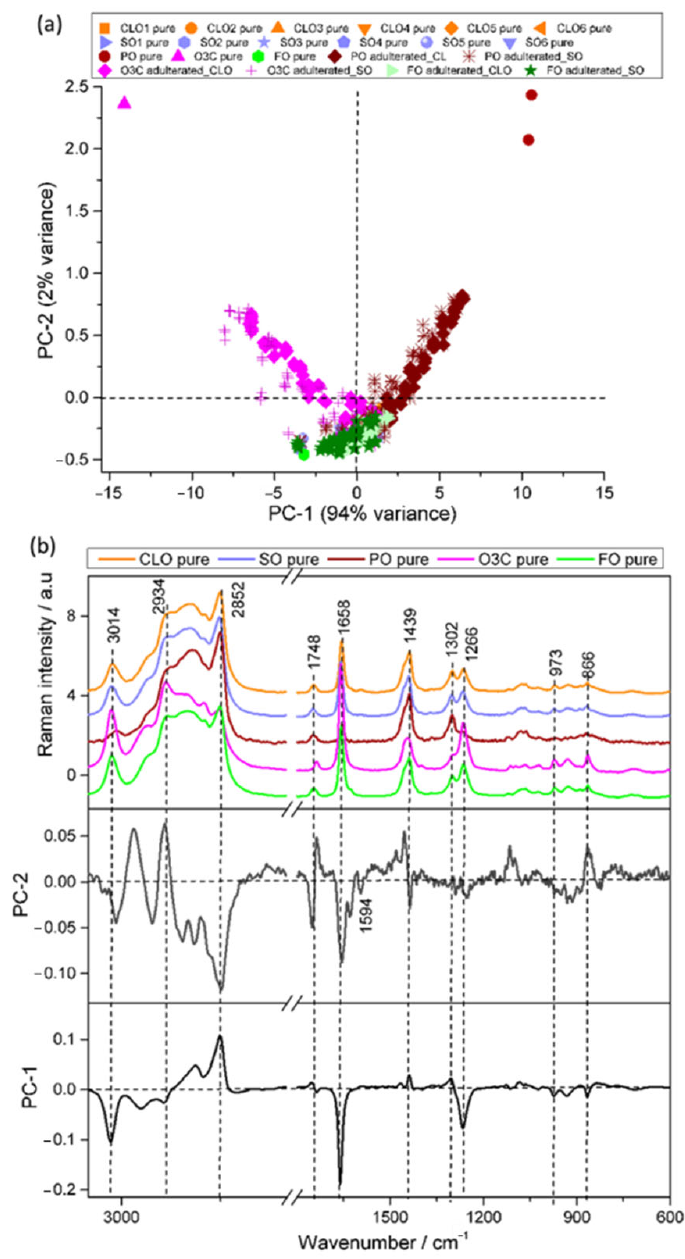
Figure 2. PCA scores and loadings of the Raman spectra collected from the CLO and SO samples adulterated with PO, O3C, and FO. ( a ) PC1 (94% explained variance) versus PC2 (2% explained variance) scores plot, and ( b ) representative Raman spectra and the associated loadings for PCs 1 and 2.